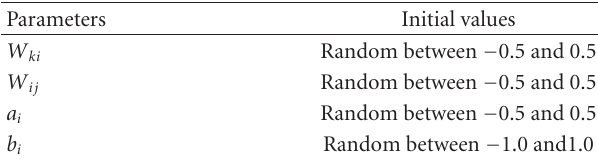
Figure 3: Sketch of the structure of WNN. Table 1: Initial values of